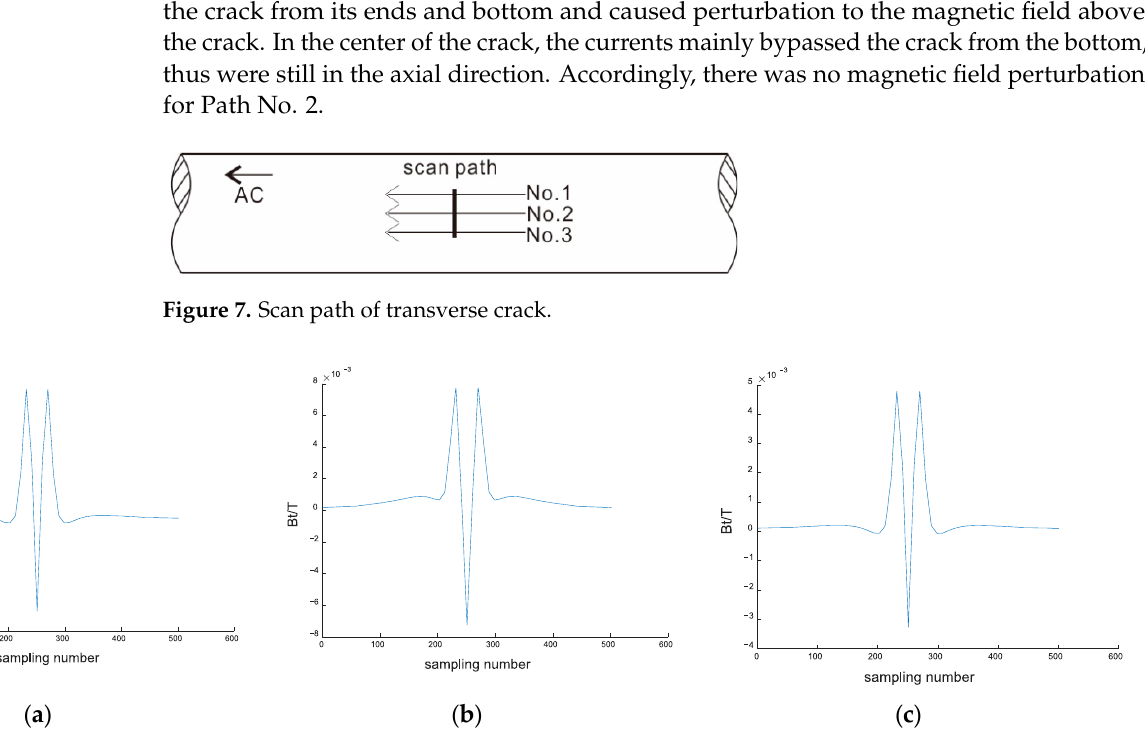
Figure 8. Simulation signal of B n in three paths: ( a ) path No. 1; ( b ) path No. 2; ( c ) path No. 3.